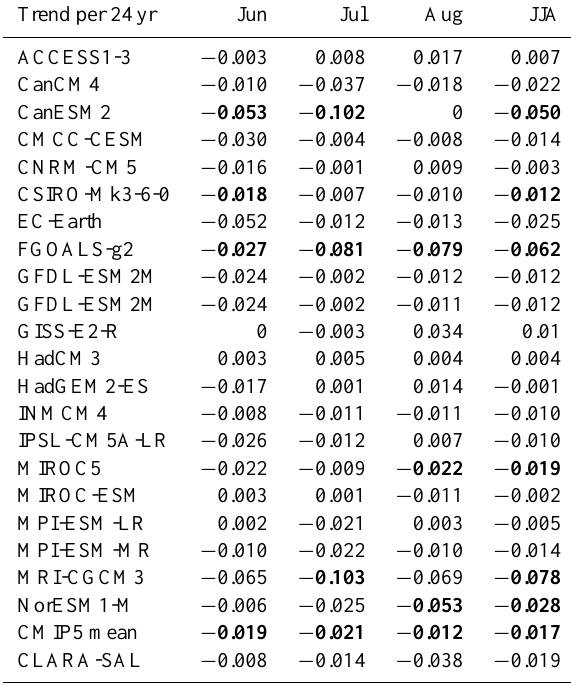
Table 1. Ice albedo trend for the period 1982–2005, averaged over 80–90 ◦ N. Trends that are significant at the 95% significance level are marked